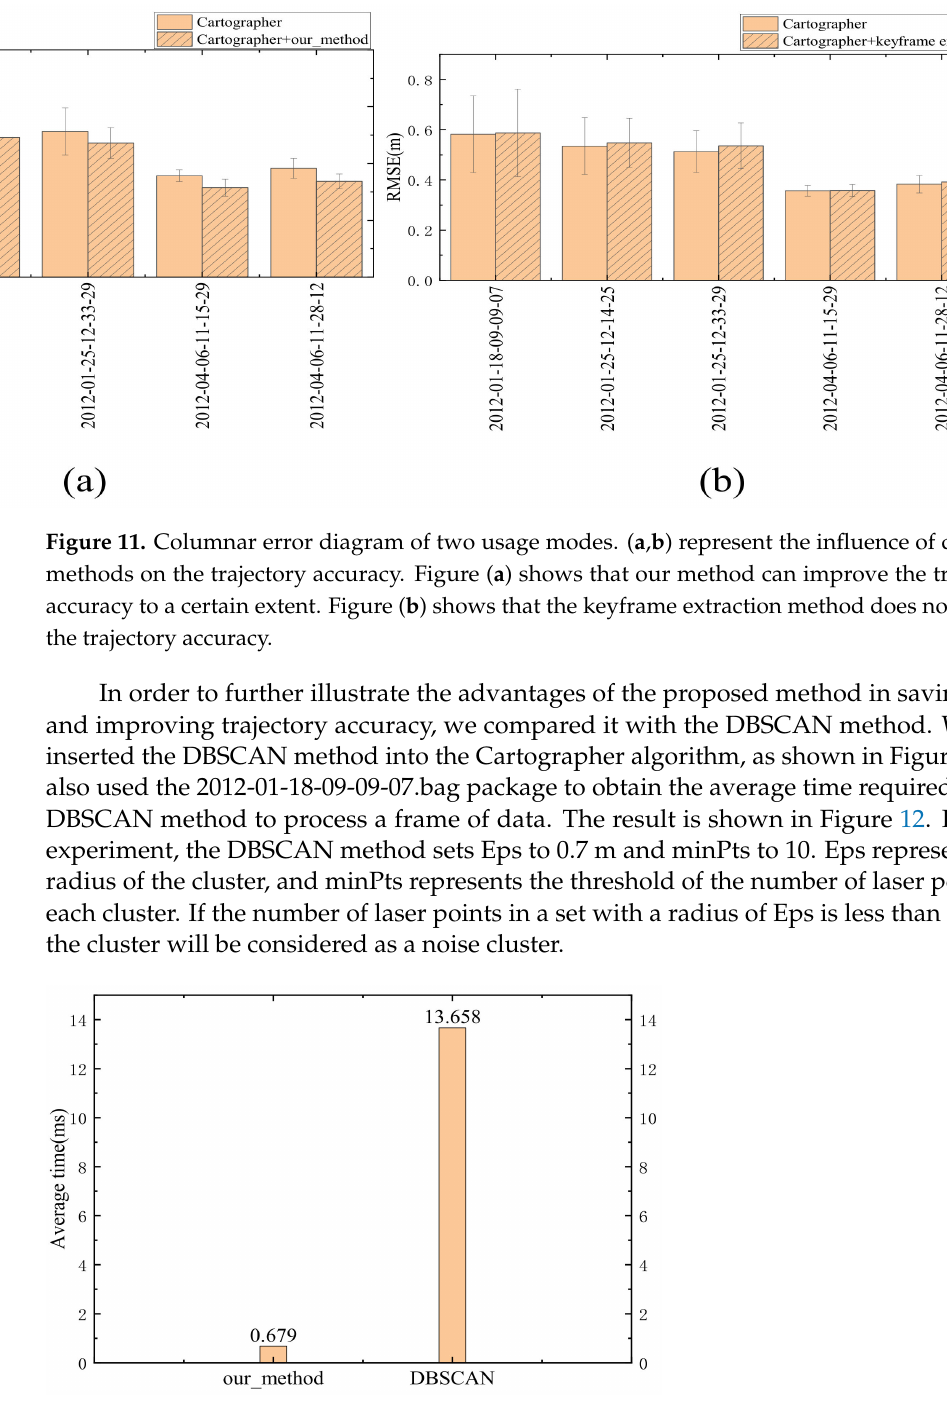
Figure 12. Comparison of the average time required by the proposed method and DBSCAN method in processing a frame of